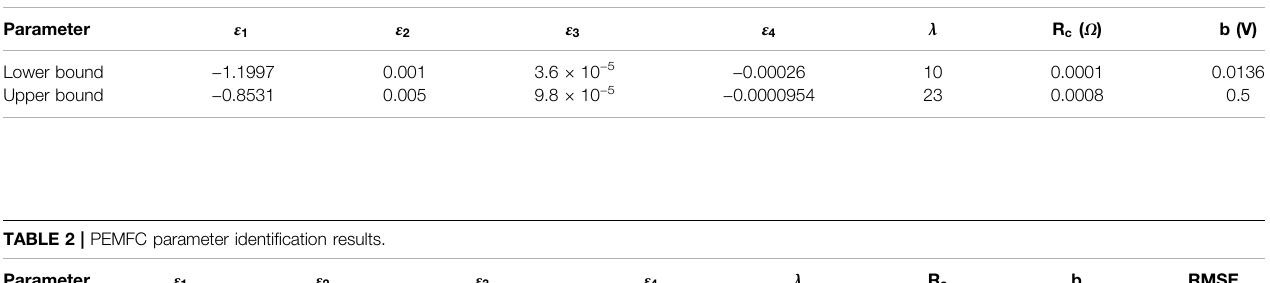
TABLE 2 | PEMFC parameter identi fi cation results. Parameter